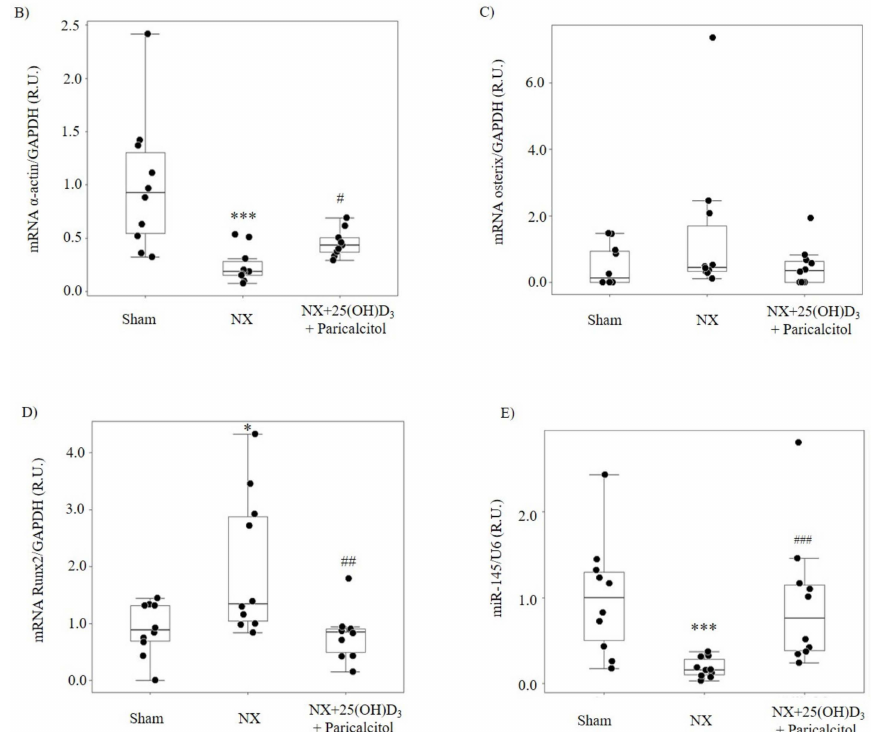
Figure 2. Vitamin D prevents uremia-induced aortic osteogenic differentiation and calcification. ( A ) Ca content, ( B ) α –actin, ( C ) osterix, ( D ) Runx2 and ( E ) miR-145 levels in aortas from mice subjected to 75% NX and exposed to vehicle (NX group, n = 10) or to the combination of 25(OH)D 3 and paricalcitol (25(OH)D 3 : 80 ng/mice i.p. weekly and Paricalcitol: 2.6 ng/mice i.p. thrice weekly; NX + 25(OH)D 3 + Paricalcitol, n = 10) for 6 weeks, after 8 weeks of uremia in mice fed a normal diet. A group with normal renal function was used as control (Sham group, n = 10). Bars and error bars represent mean ± SD and box plots represent median and interquartile range; R.U.: relative units. * p < 0.05 and *** p < 0.001 vs. Sham and # p < 0.05, ## p < 0.01 and ### p < 0.001 vs. NX